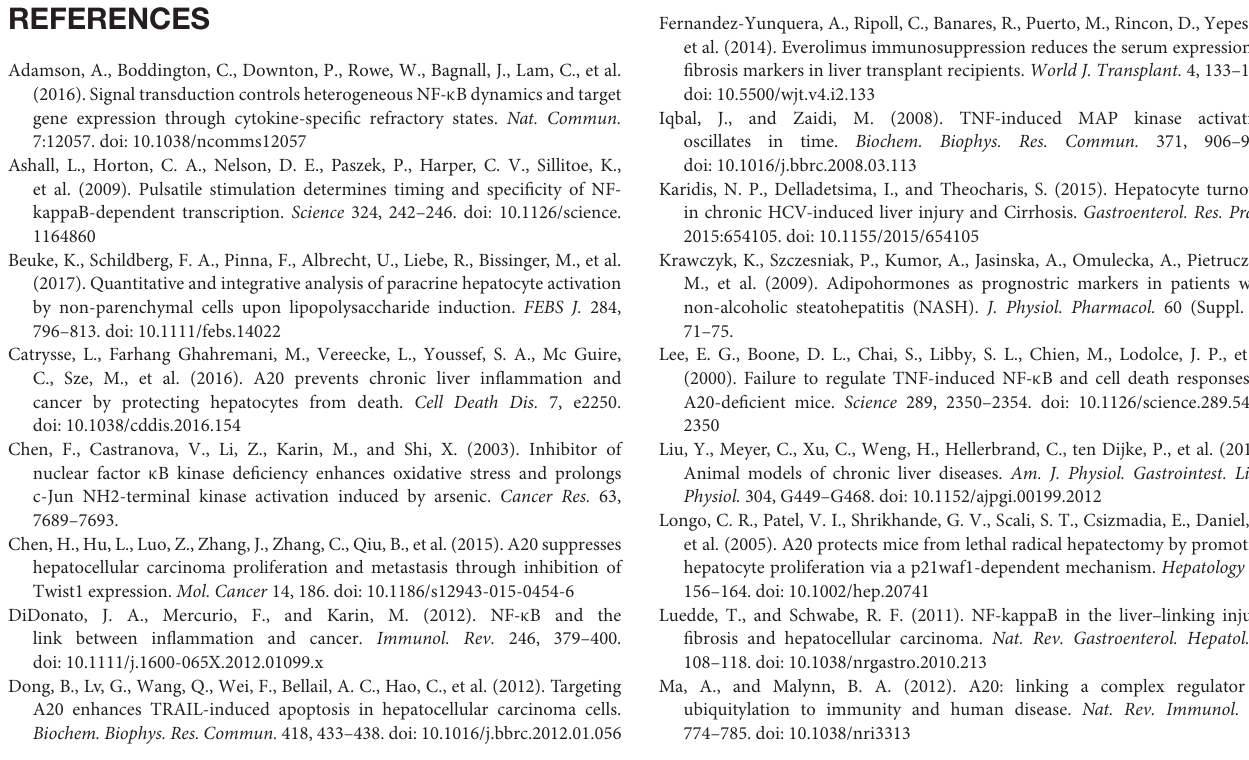
NF- κ B and JNK pathways constituents in Hep56 cells after single TNF administration (10 ng/ml). (C) Relative mRNA levels of I κ B α and A20 after single TNF stimulation. Bars in panel (C,D) represent standard errors. Supplementary Figure S2 | Comparison of NF- κ B and JNK pathway activity in Hep56 cells after single and multiple TNF stimulation. This experiment was performed as described for Hepa1-6 cells (Figure 4). For this analysis, only time points were chosen, which showed differential signal amplitude between NF- κ B and JNK in Hepa1-6 cells (untreated, 10, 70, and 130 min after TNF administration). (A) Single TNF treatment of Hep56 cells (1 × 1 ng/ml). (B) Triple TNF treatment Hep56 cells with 1 × 1 ng/ml followed by 2 × 2.5 ng/ml. (C) Triple TNF treatment Hep56 cells with 1 × 1 ng/ml followed by 2 × 5 ng/ml. For all graphs signals for p65/phospho-p65, and JNK/phospho-JNK were quantified and normalized to the respective loading control (actin). Bars represent standard errors. Supplementary Figure S3 | Confirmation of transfection efficiency of pCMV6 vectors. (A) Six technical replicates of Hepa1-6 clones transfected with pCMV6-A20 were tested for the overexpression of pMax-GFP. Test was repeated after establishment of individual clones (six clones are shown). (B) Brightfield and immunofluorescence pictures of Hepa1-6 cells after transient transfection of the pMax-GFP vector. Note that the majority of cells show moderate to strong positivity for GFP. (C) FACS analysis confirms that about 80% of all cells are positive for GFP. Supplementary Figure S4 | Changes in A20 expression do not affect p65 activity. (A) A20 overexpression does not affect p65 or its target gene I κ B α . Transcript levels of A20, I κ B α , and p65 were measured by real-time PCR. (B) Luciferase assay illustrates that A20 overexpression does not change the activity of p65. Bars represent standard errors. Supplementary Figure S5 | Analysis of HCC apoptosis after A20 inhibition and TNF stimulation. A20 was inhibited in Hep56 cells by gene-specific siRNA transfection. Twenty-four hours later cells were treated with TNF (10 ng/ml) and apoptosis was measured after indicated time